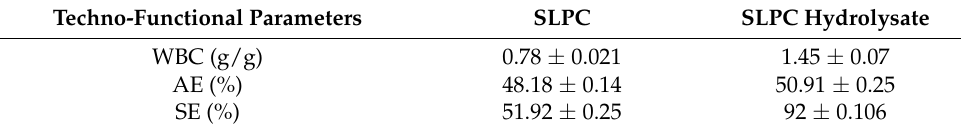
Table 6. Techno-functional properties. Techno-Functional